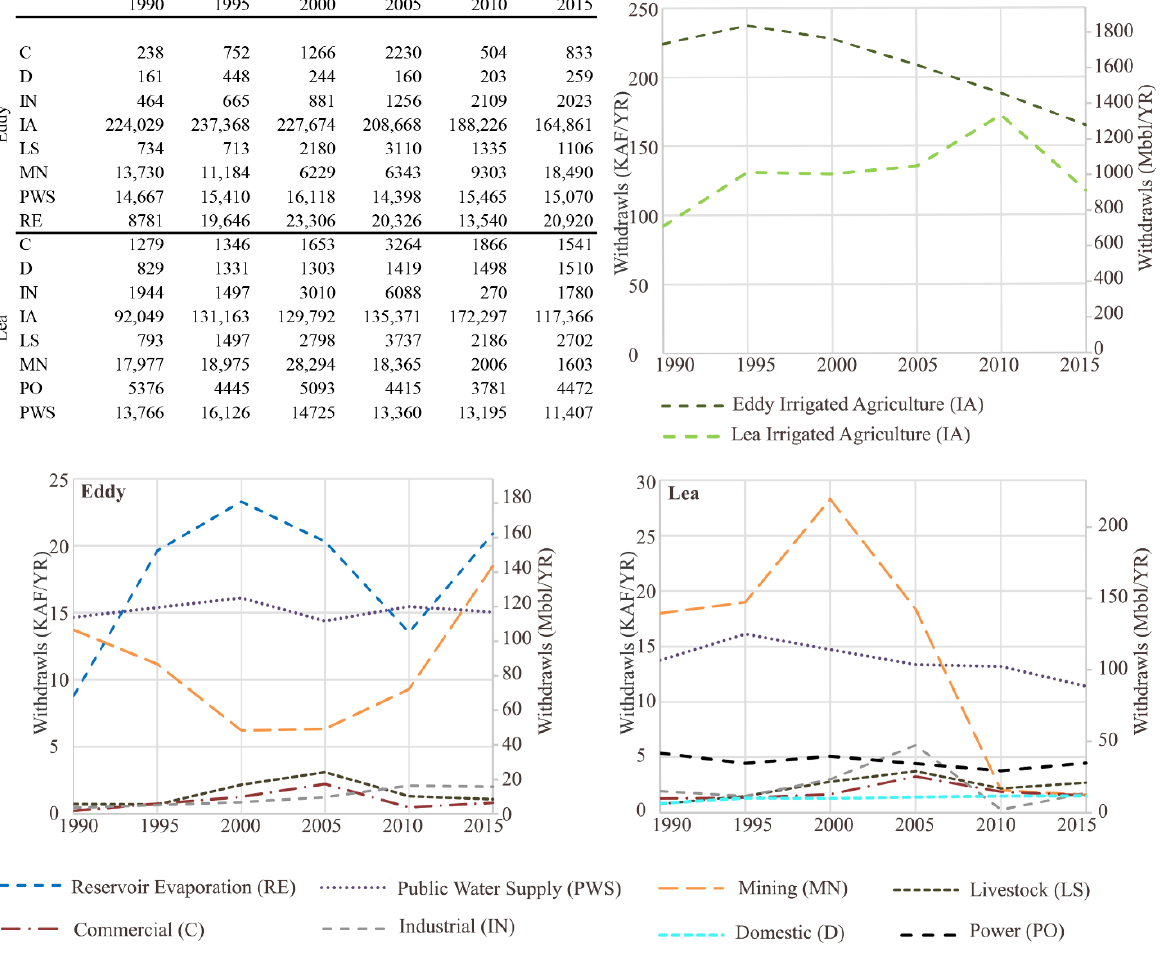
Figure 4. Trends of fresh water withdrawals in 1000 acre-feet per year (KAF/YR) by category for Eddy County and Lea County from New Mexico Office of the State Engineer reports between 1990 and 2015. Table volumes in acre-feet.